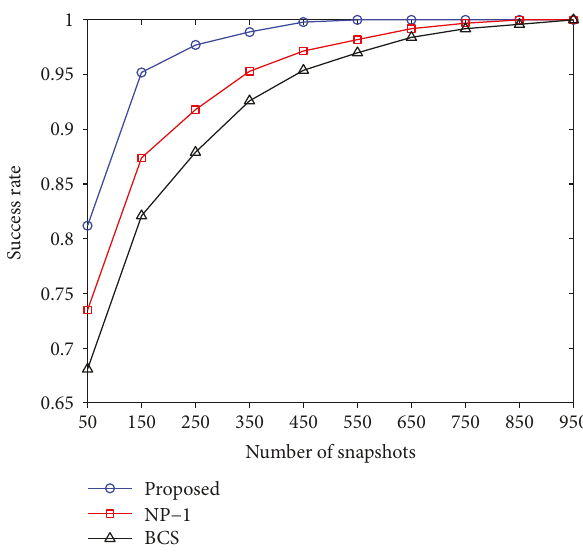
Figure 4: Success rates versus number of snapshots with the fi xed SNR 0 dB.